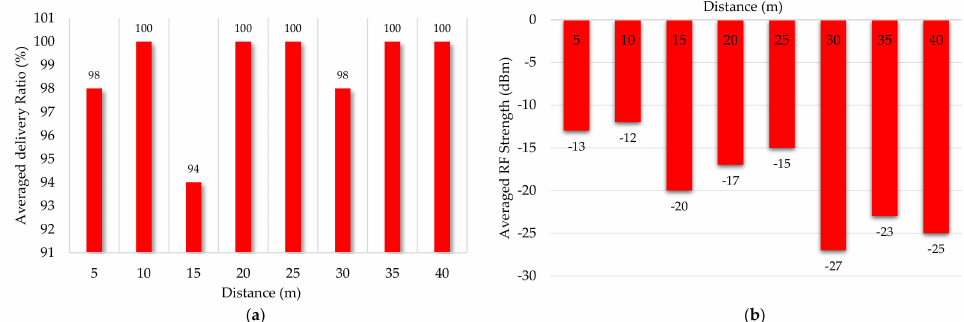
Figure 13. Result of the wireless communication tests for the long corridor in the shelter deck. ( a ) Average delivery ratio and ( b ) average radio frequency strength (redrawn based on data in Paik et al.